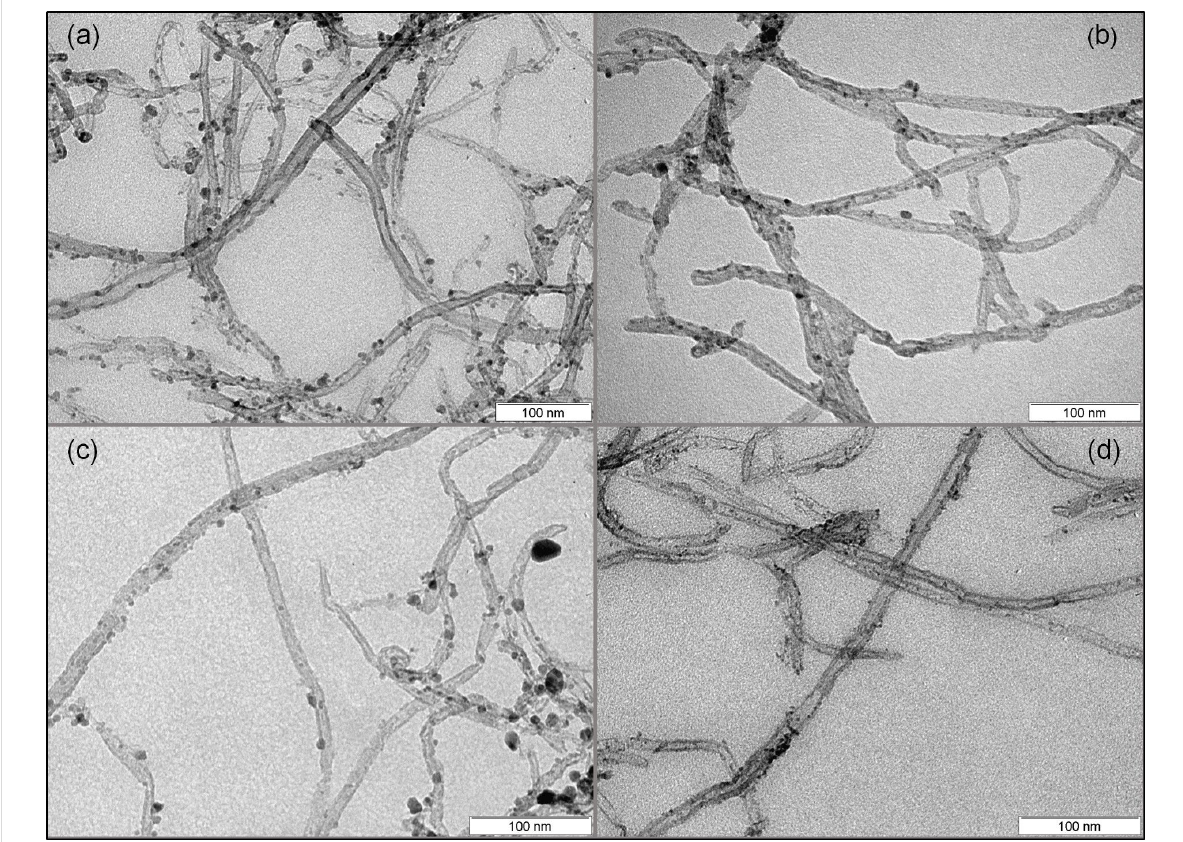
Figure 2: Different decoration homogeneity using different solvents, methanol (a), ethanol (b), DMF (c) and acetone (d).